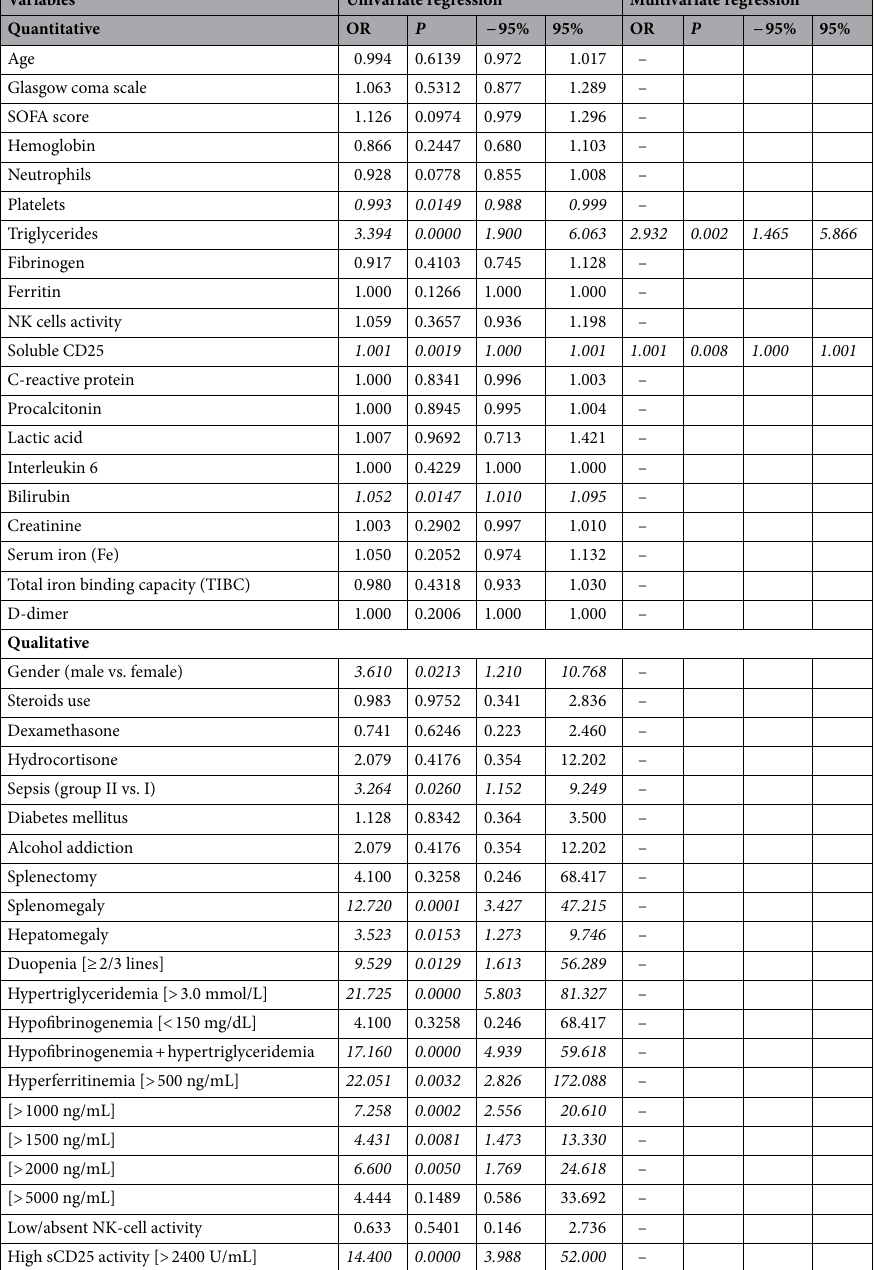
Table 4. Variables associated with the occurrence of SHLS (n = 104. Univariate logistic regression and multivariate stepwise regression—for quantitative variables with p < 0.2 for the model; for qualitative variables—model unavailable). OR, odds ratio; 95Cl, 95% Confidence Interval; sCD25, Soluble CD25. The level of statistical significance was determined with the value of ( p <